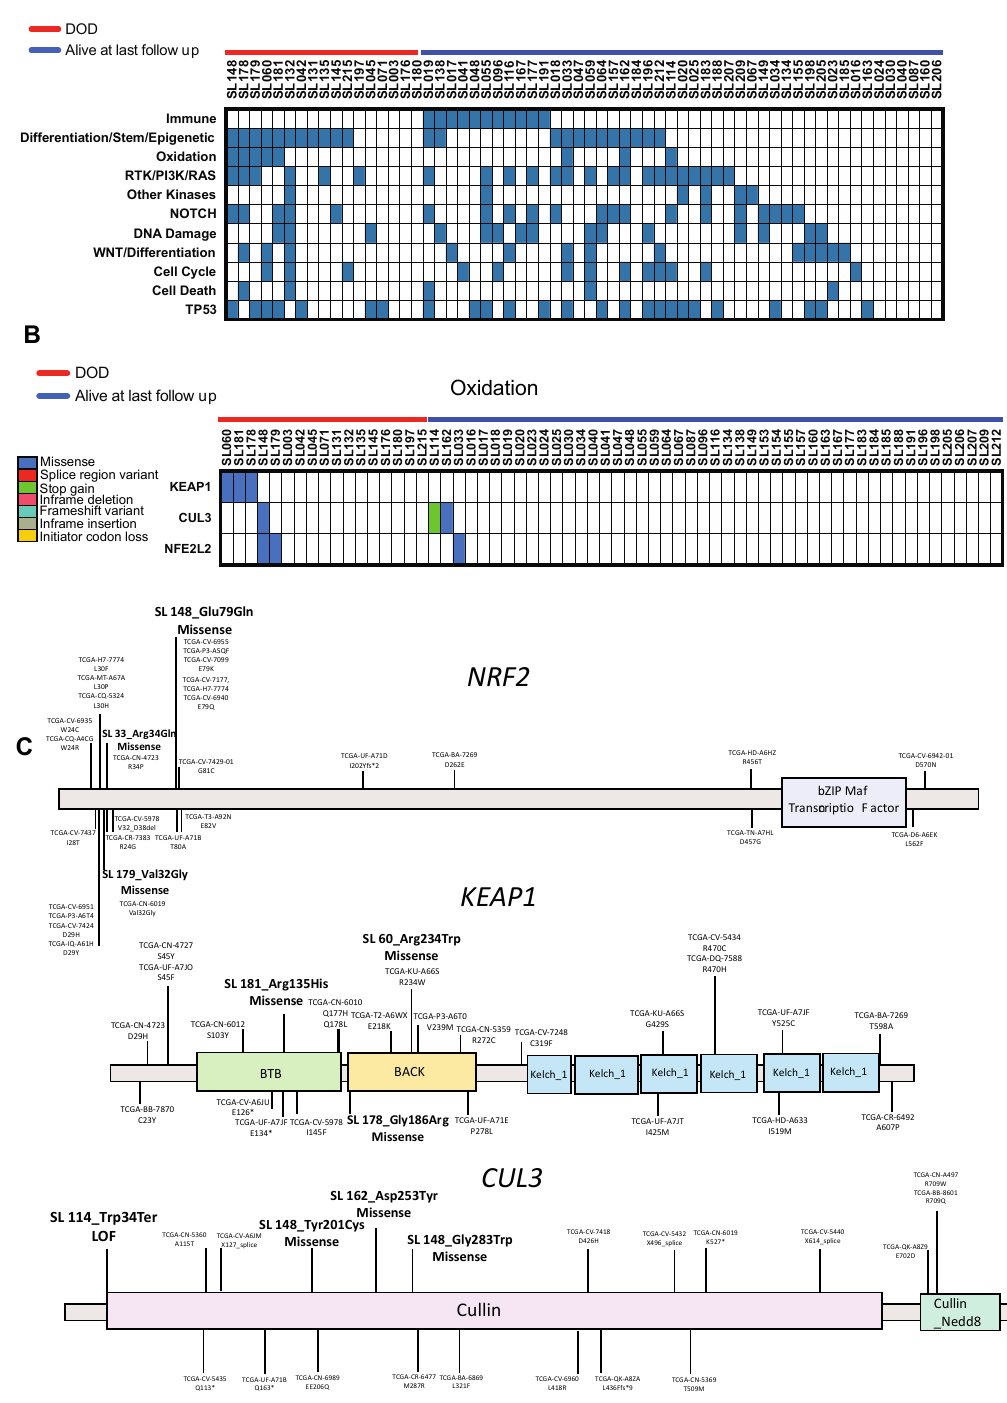
Figure 2. Mutation frequency by pathway and by gene. Oncoplots demonstrating mutations grouped by pathway ( A ) and by gene for Oxidation pathways ( B ). Mutations are clustered by survival (DOD = dead of disease vs. alive) along the top. ( C ) Schematic of mutation location for key genes in Oxidation pathway ( NRF2, KEAP1, and CUL3 ) in our samples relative to mutations from primary laryngeal tumor specimens from TCGA.